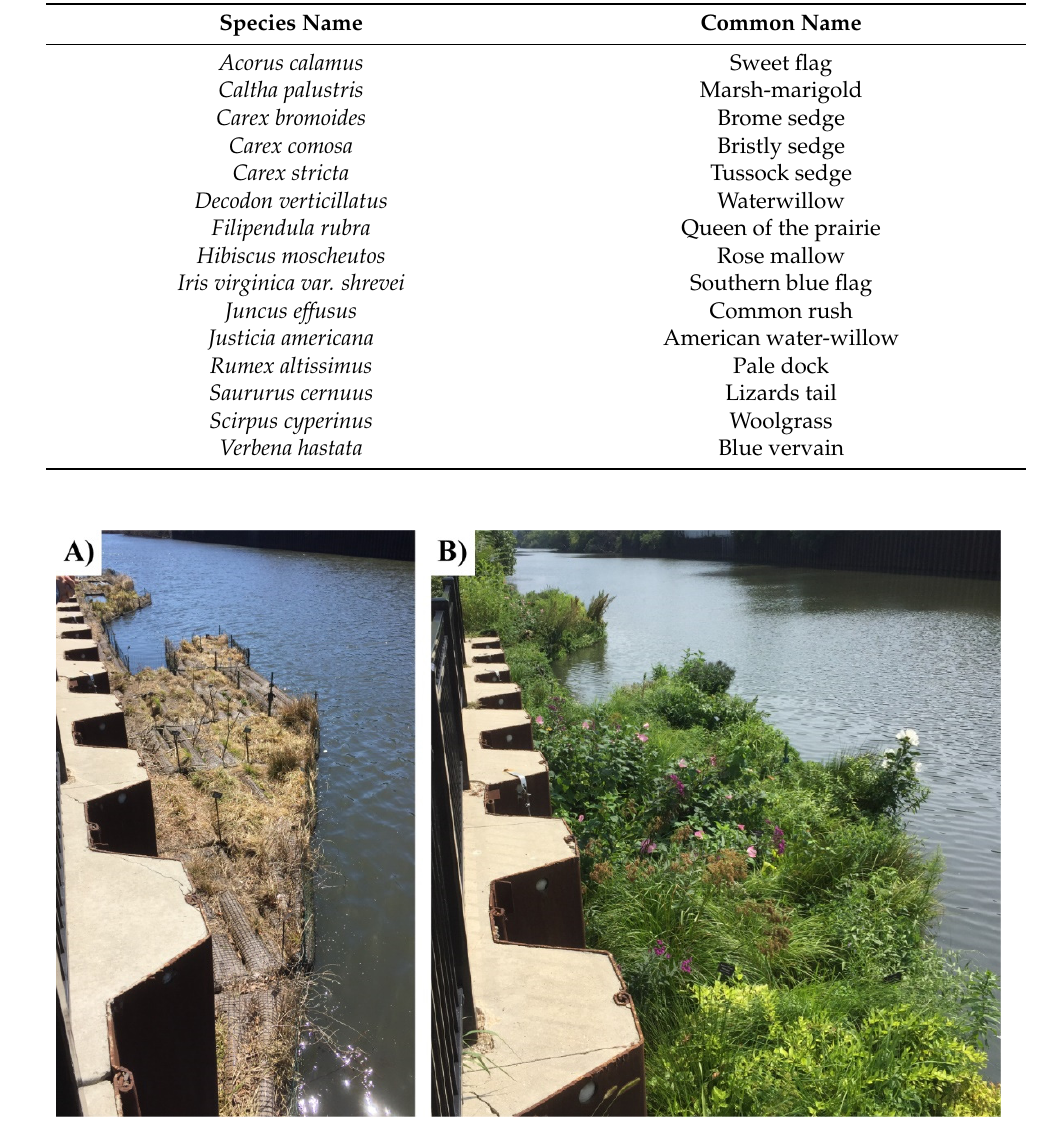
Figure 2. ( A ) AFWs during the dormant period (April 2019). ( B ) AFWs during the growing period (August 2019). Table 1. Plant species that have experienced successful growth in the AFWs.